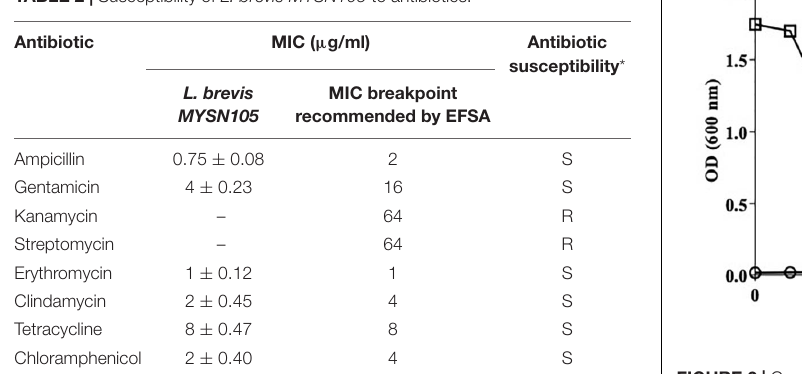
TABLE 2 | Susceptibility of L. brevis MYSN105 to antibiotics.